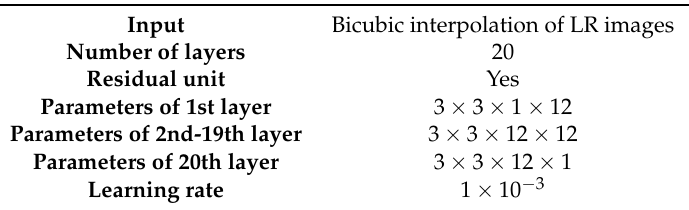
Figure 3. Network structure of VDSR used in this paper. ILR, interpolated low-resolution image; R_image, residual image. Table 3. Parameters of VDSR used in this